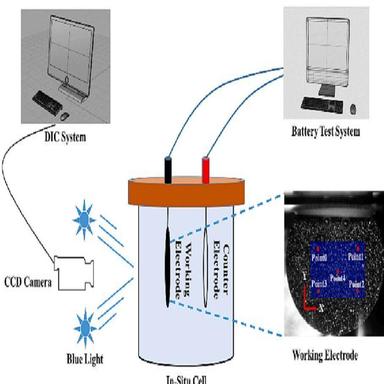
Schematic illustration of the in-situ strain test system.